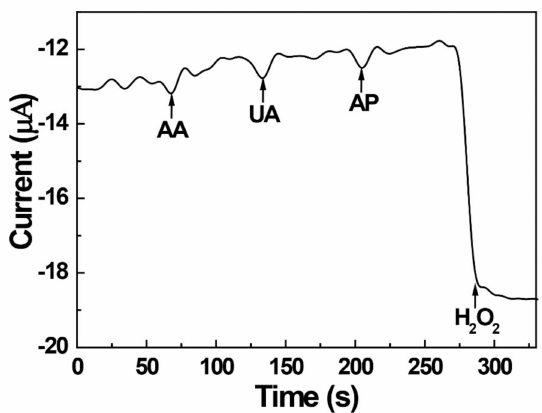
Figure 6. Amperometric responses of the AgNPs / PEI-decorated GCE to injections of 0.5 mM ascorbic acid (AA), uric acid (UA), acetaminophen (AP), and H 2 O 2